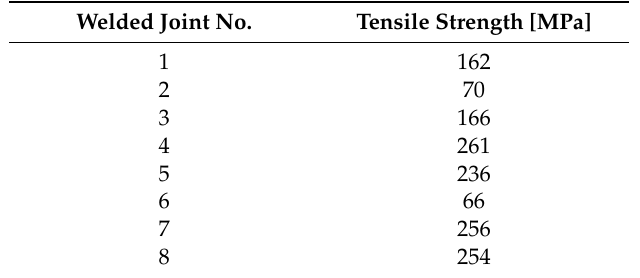
Table 8. Measured tensile strength for dissimilar metals-welded joints. Welded Joint